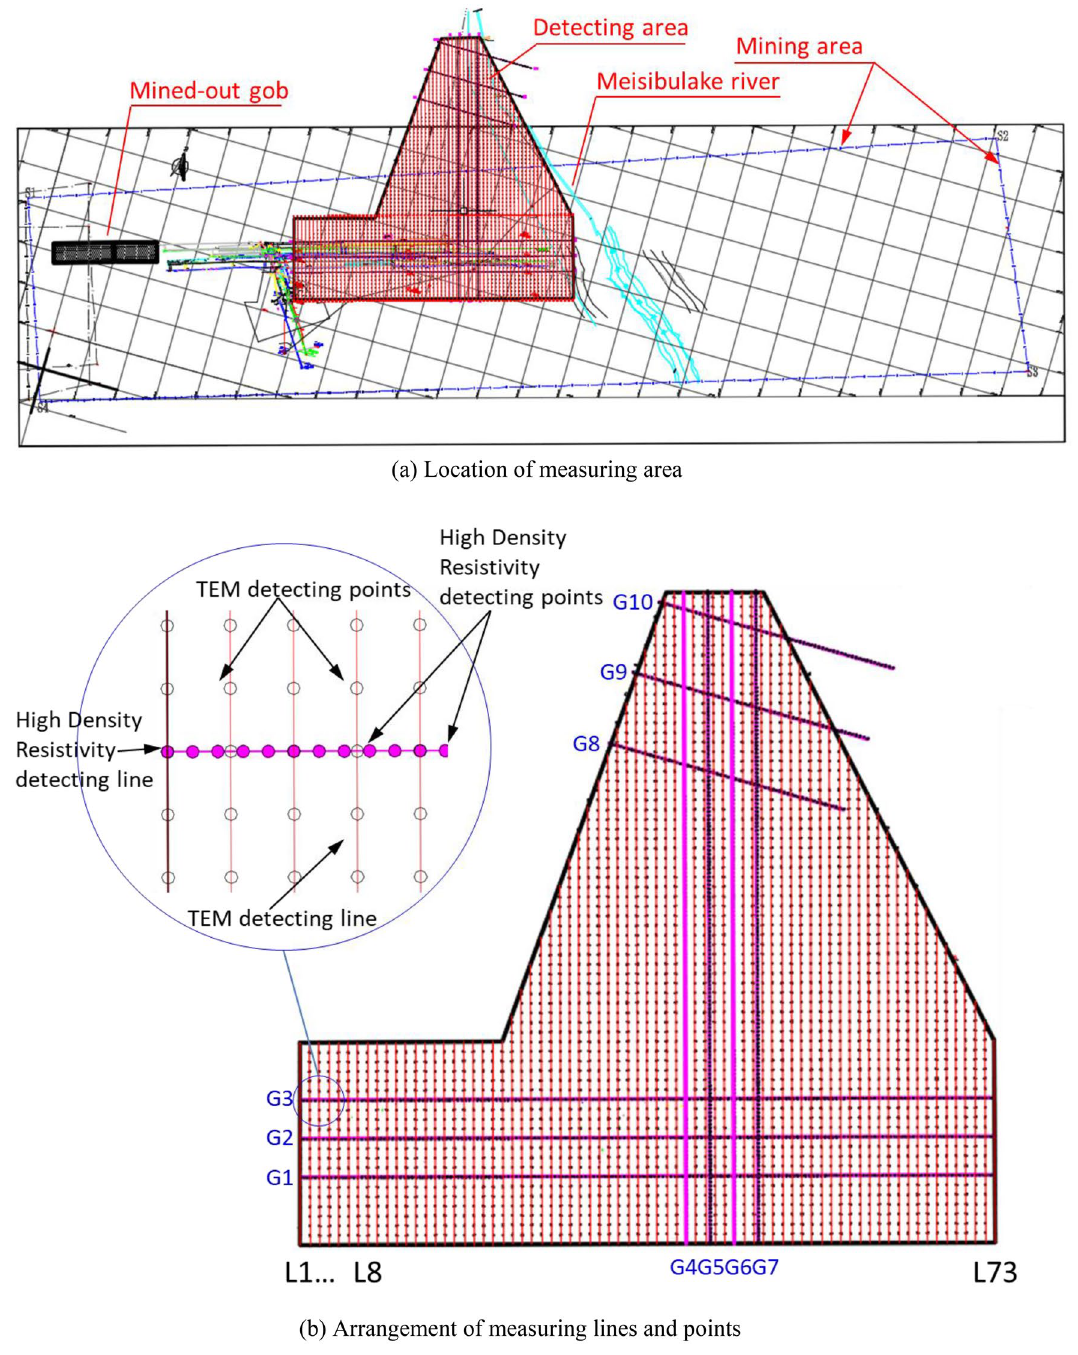
Figure 2. Measuring area. ( a ) Location of measuring area ( b ) Arrangement of measuring lines and